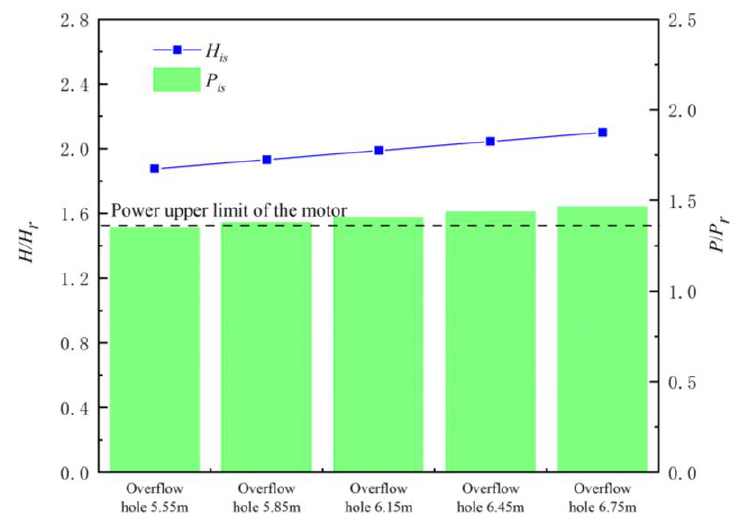
Figure 9. H is and P is of LAPS with OVHO under gate refusal working